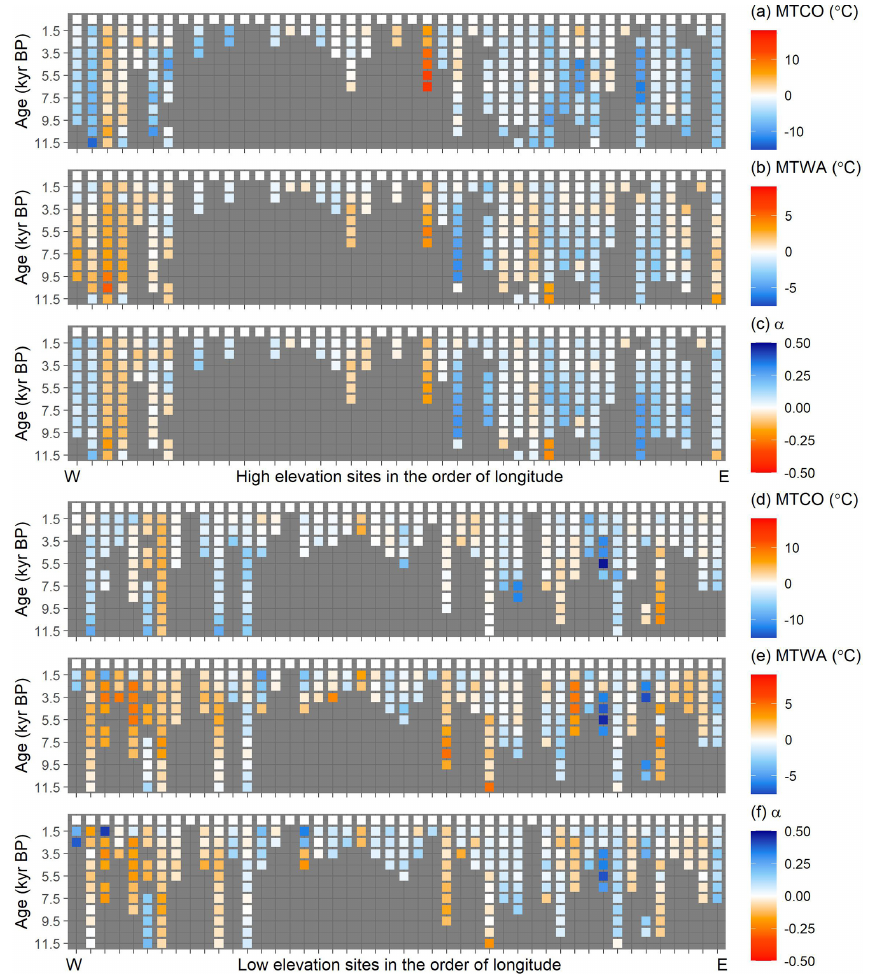
Figure 3. Reconstructed anomalies in climate at individual sites through time. The sites are grouped into high- ( > 1000m) and low- ( < 1000m) elevation sites and organized from west to east. Grey cells indicate periods or longitudes with no data. The individual plots show the anomalies in reconstructed (a,d) mean temperature of the coldest month (MTCO), (b,e) mean temperature of the warmest month (MTWA) and (c,f) plant-available moisture as represented by α , an estimate of the ratio of actual evapotranspiration to equilibrium evapotran- spiration. The anomalies are expressed as deviations of the mean value in each bin ( ± 500 years) from the most recent bin (0.5ka ± 500 years) at each